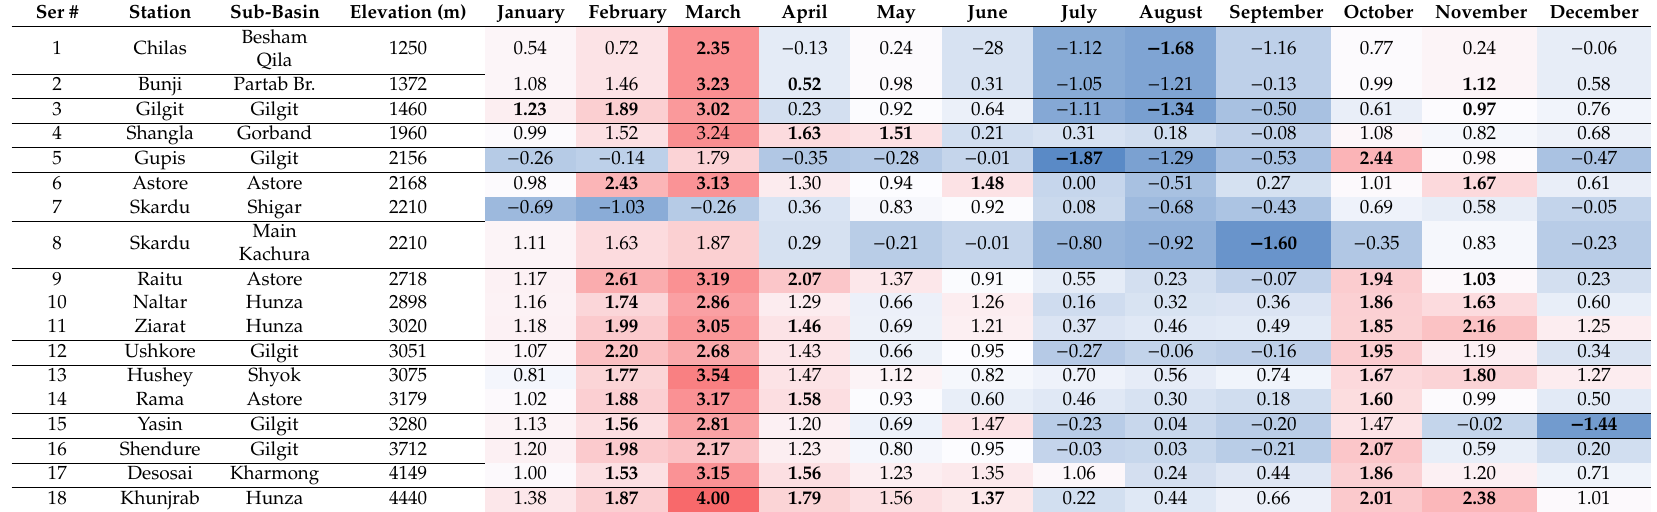
Table 9. Changes in mean monthly averaged temperatures ( ◦ C) from 1981 to 2010 for stations located at di ff erent altitudes in the Upper Indus Basin